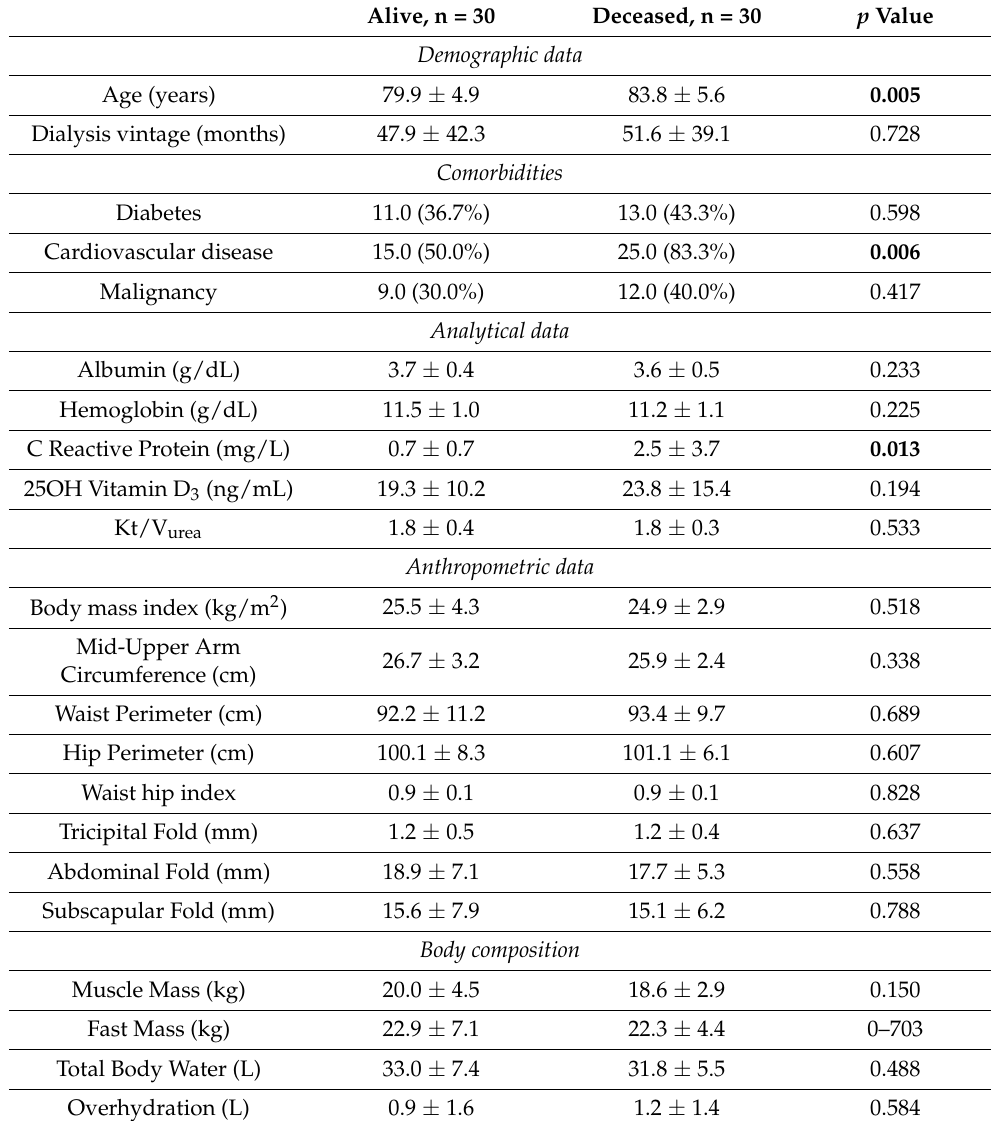
Table 4. Characteristics of patients alive or deceased at 2 years. Data shown as mean ± SD, n (%). Alive, n =